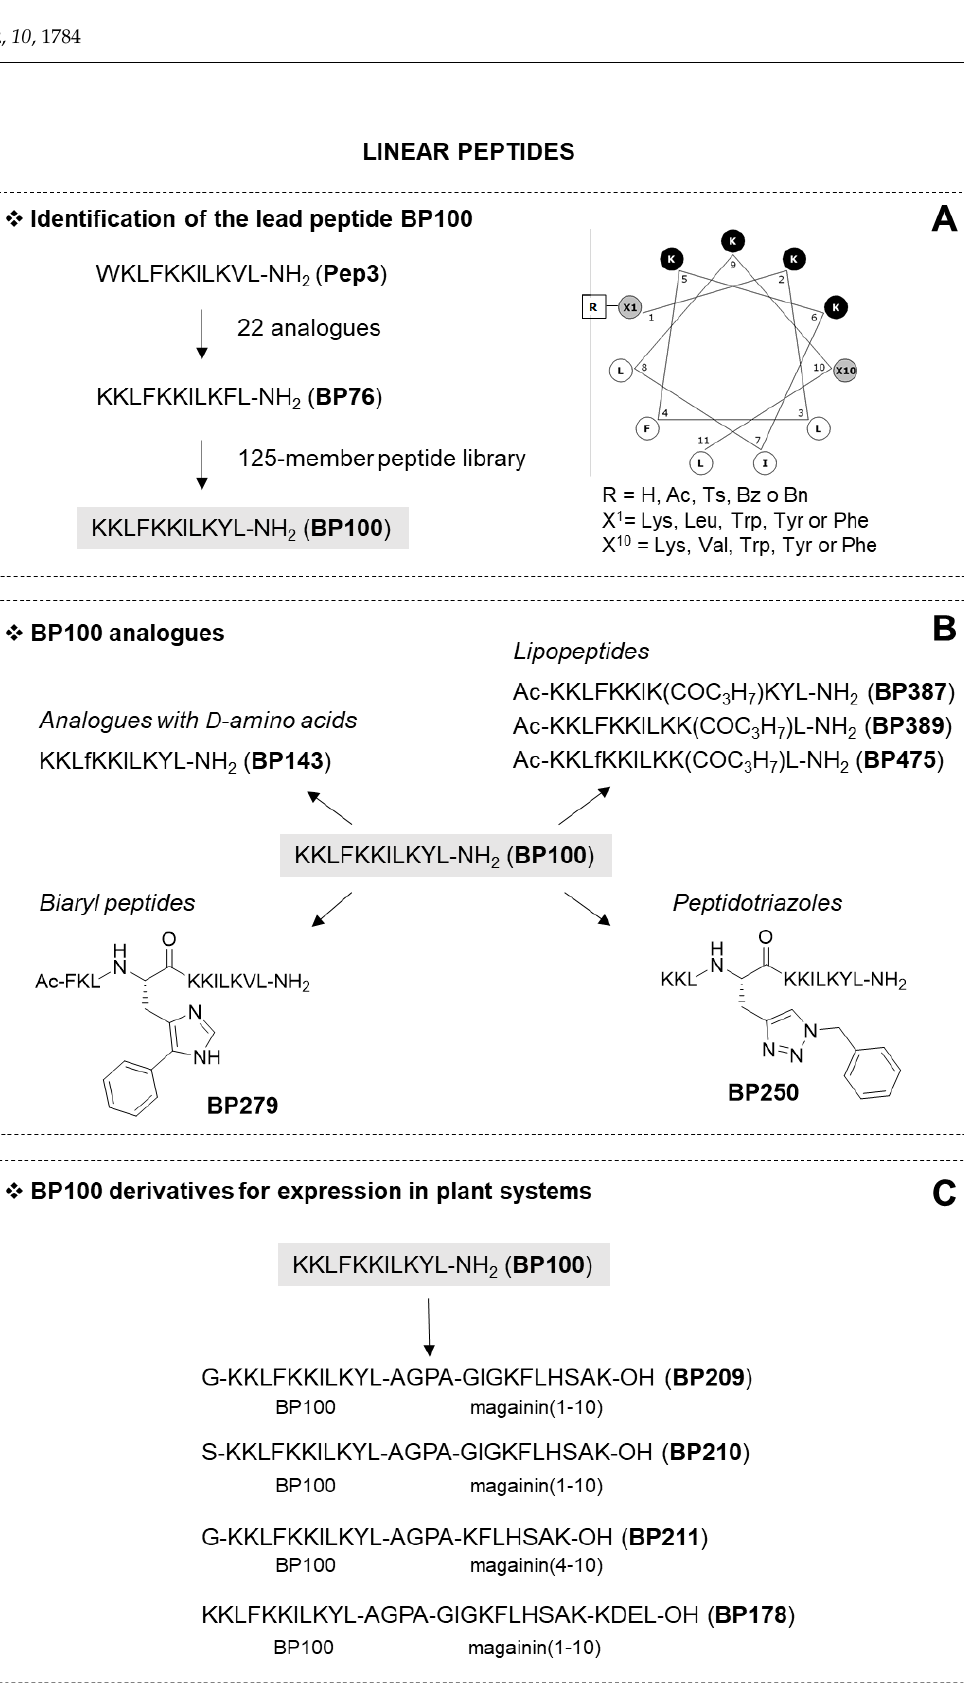
Figure 1. Linear peptides. Identification of the lead peptide BP100 ( A ) [36,37], design of analogues ( B ) [39 – 44], and derivatives for expression in plant systems ( C ) [46], as described in Section 2.1.